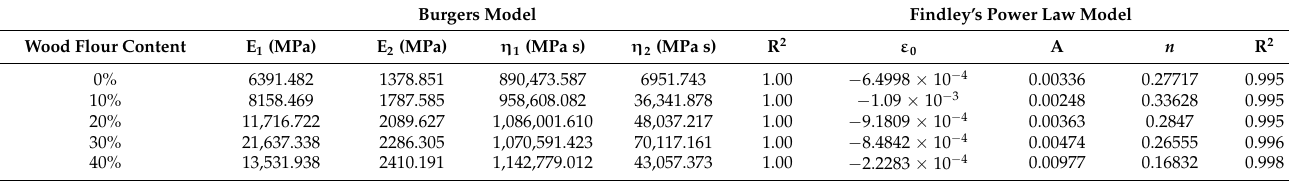
well the viscosity stage. Therefore, it may be more suitable to fit only short-term creep data. The results were in good agreement with the previous literature [43,47]. Table 3. Parameters of Burgers model and Findley’s power law model. Burgers